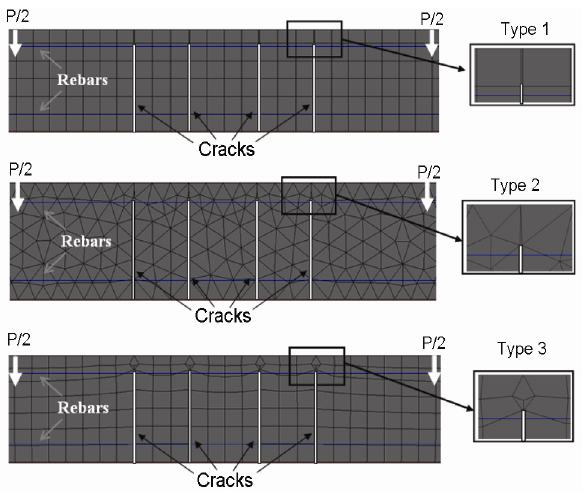
Fig. 11. Different mesh layouts for crack tips